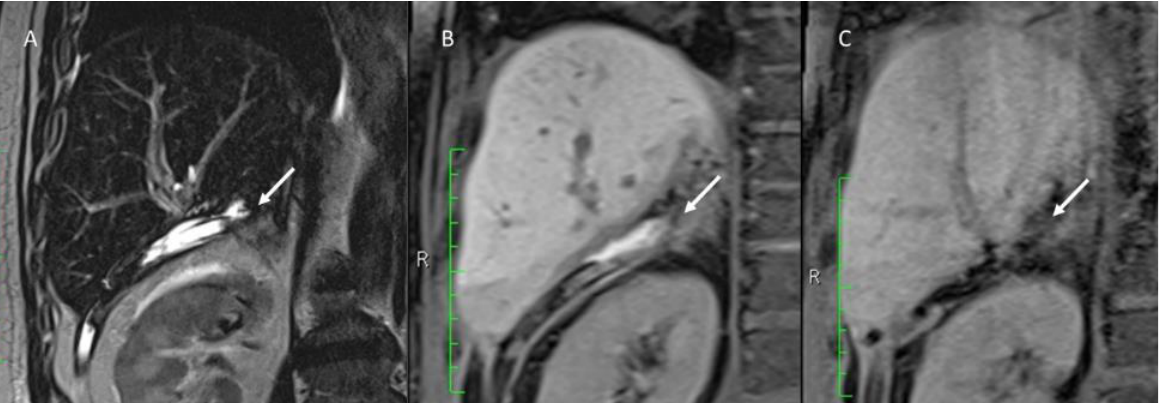
Figure 7. Post-surgical MRI assessment. In ( A ) T2-W sequences shows (arrow) fluid collection. In ( B ), On EOB-phase, bile leak is detected as an active overflow of contrast material outside biliary tree and inside the fluid collection (arrow). In ( C ) EOB-phase post bile leak treatment evaluation, no overflow of contrast medium.